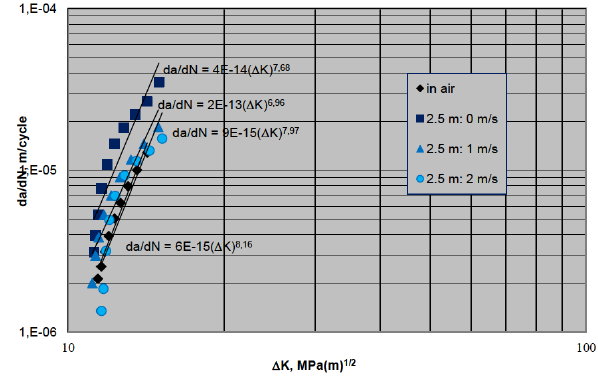
Figure 8: da/dN - ∆ K diagram for underwater wet welding in water depth of 2.5